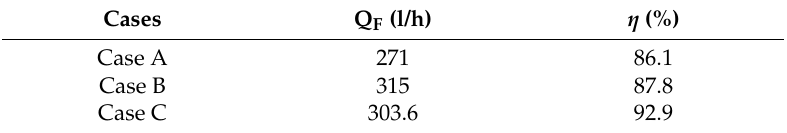
Figure 12. CO, CO 2 , O 2 , NO x emissions under different operating conditions. Case A: firing HFO without cleaning the boiler tubes; Case B: firing emulsified HFO with 20 vol% water without cleaning the boiler tubes; Case C: firing emulsified HFO with 20 vol% water after cleaning the boiler tubes. Table 3. Variations in boiler performance with fuel type and operating